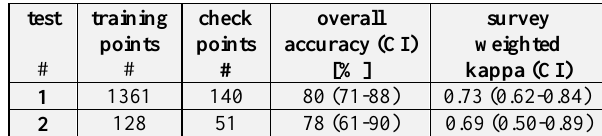
Figure 6. Generated interpreted façade plot with four classes (”vegetation”=green, ”stonework”=orange, ”painted wall”=white, ”window”=black) and coordinate axes with units in meters The rearmost façade is classified with the correct height above ground. The other two facades have to use modified ground heights and need to be classified in addition. The assessment of façade, the four classes can clearly be distinguished. The edges